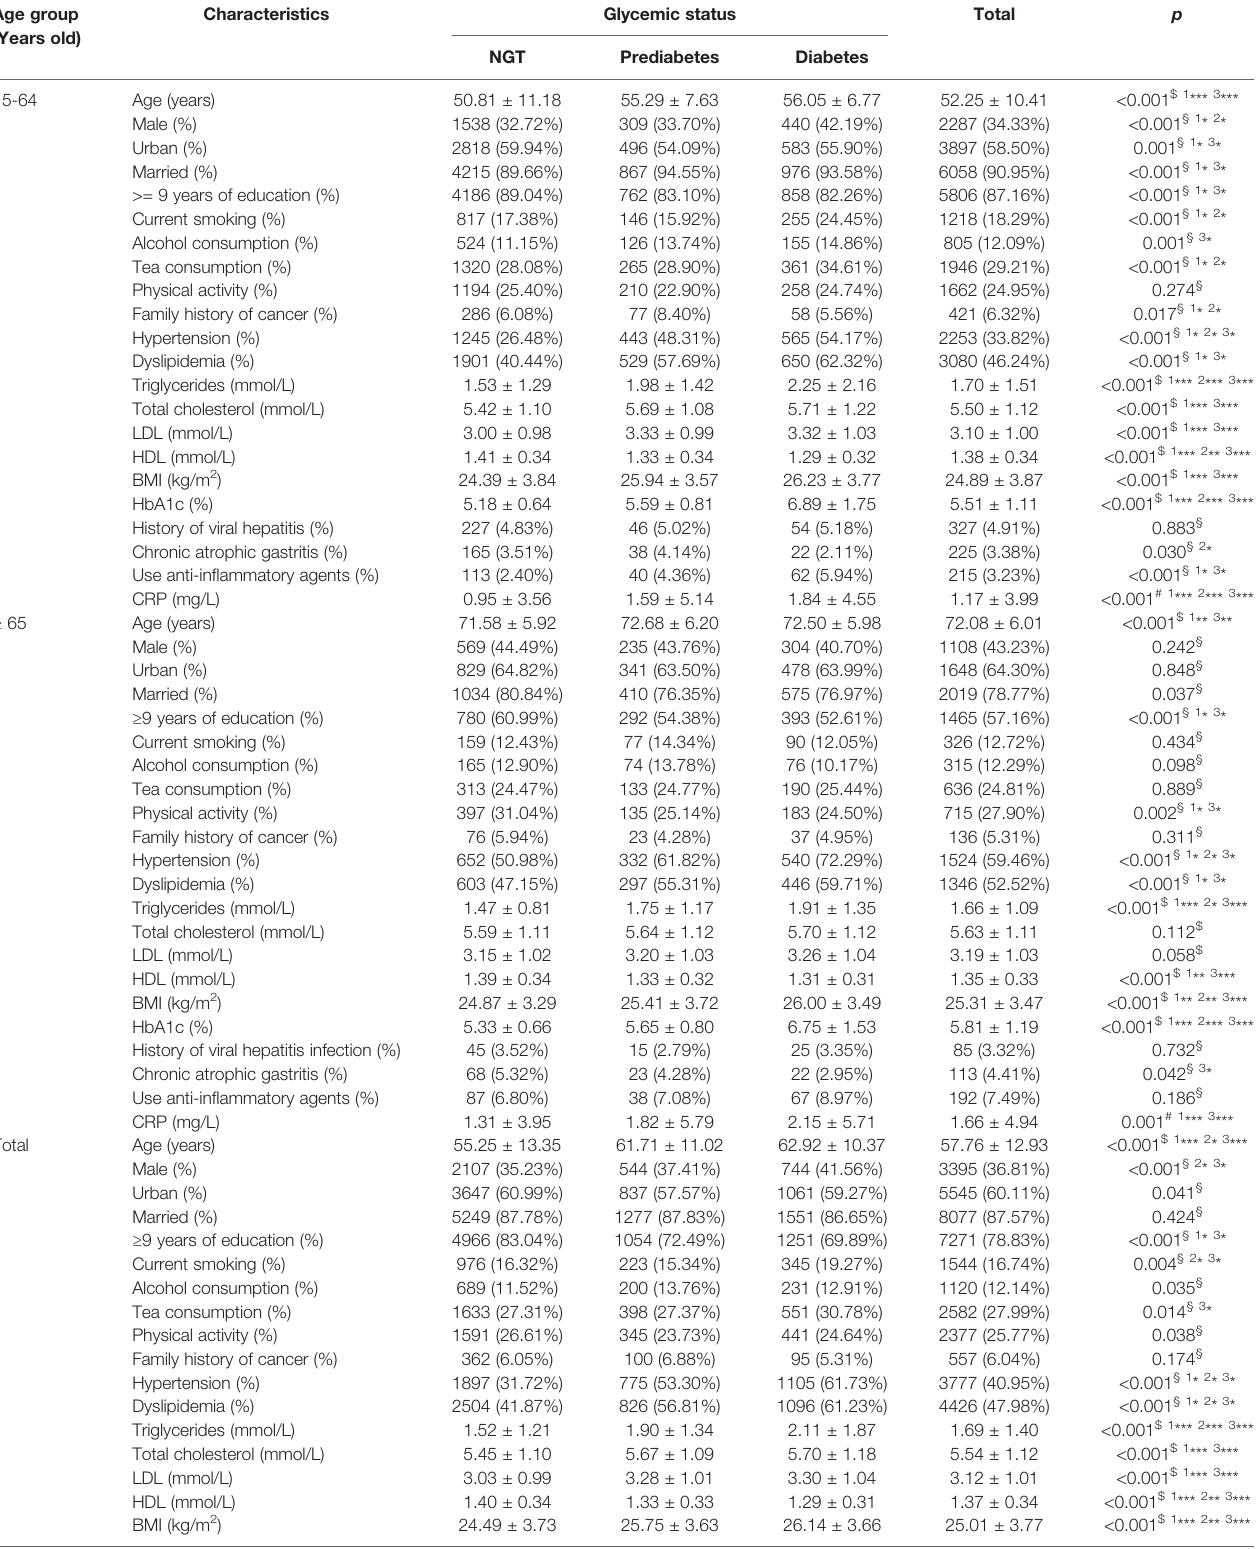
TABLE 1 | Baseline participant characteristics strati fi ed by glycemic status. Age group (Years